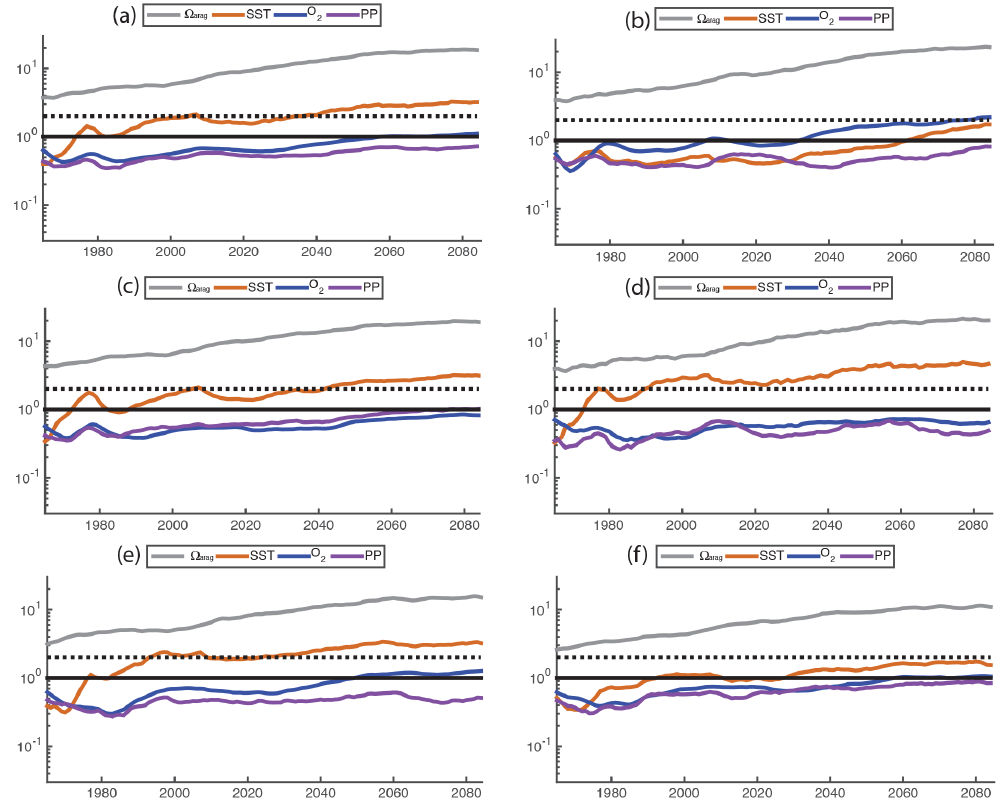
Figure 1. Time series of (area weighted) averages of signal-to-noise ratio (SNR) for four marine ecosystem drivers, considered over a number of ocean regions: (a) Global, (b) 90–45 ◦ S, (c) 45–15 ◦ S, (d) 15 ◦ S–15 ◦ N, (e) 15–45 ◦ N, and (f) 45–90 ◦ N. The four drivers are (cid:127) arag , SST, O 2 inventories, and NPP. For each driver, trends have been calculated individually on a gridpoint-by-gridpoint basis using a 30-year trend window, and the SNR was subsequently calculated. The vertical axis has a logarithmic scale (non-dimensional) representing the SNR. The 1-standard-deviation threshold is shown as a solid horizontal line, and the 2-standard-deviation threshold is shown as a dashed line in each